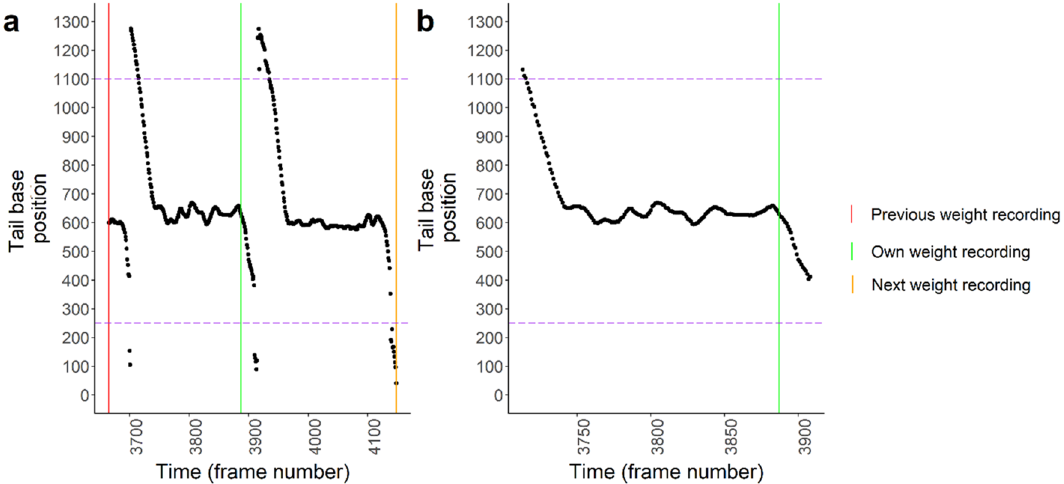
Figure 3. Determination of time window for a weight recording. ( a ) First, a subset is created as all tail base x-positions between time of recording of the next (orange) and previous (red) weight recording. The start time of the time window is determined as the first value before the own weight recording (green) above the threshold of 1100 pixels (dashed purple line; pig entering weighing scale). The end time of the time window is determined as the first value after the own weight recording (green) below the threshold of 250 pixels (dashed purple line; pig leaving weighing scale). ( b ) The extracted time window on which body part dimensions will be estimated and trajectory analysis will be